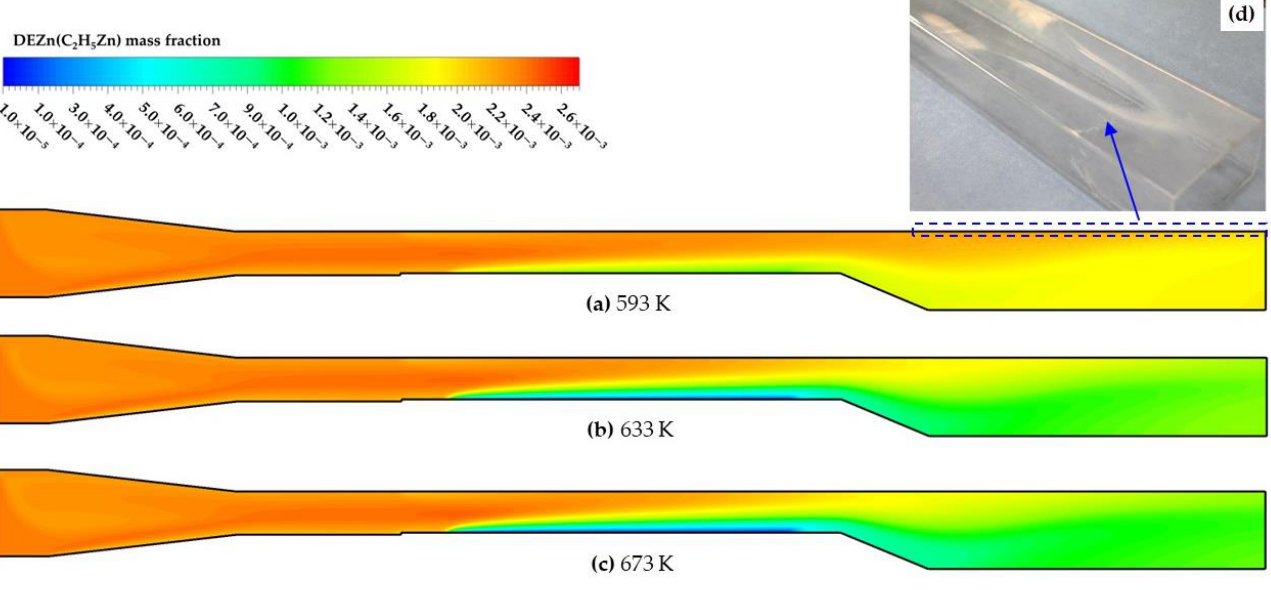
Figure 9. Contours of concentration distribution of DEZn species at the mid-plane of horizontal MOCVD reactor at temperature of ( a ) 593 K; ( b ) 633 K and ( c ) 673 K; and ( d ) the excess film deposited on top wall of the reactor.